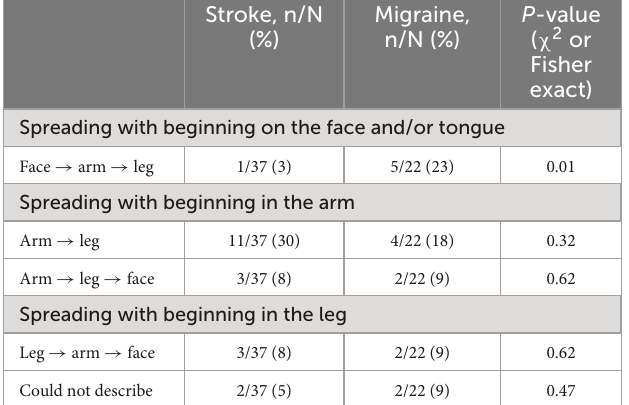
Stroke, n/N Migraine, P -value (%) n/N (%) ( χ 2 or Fisher